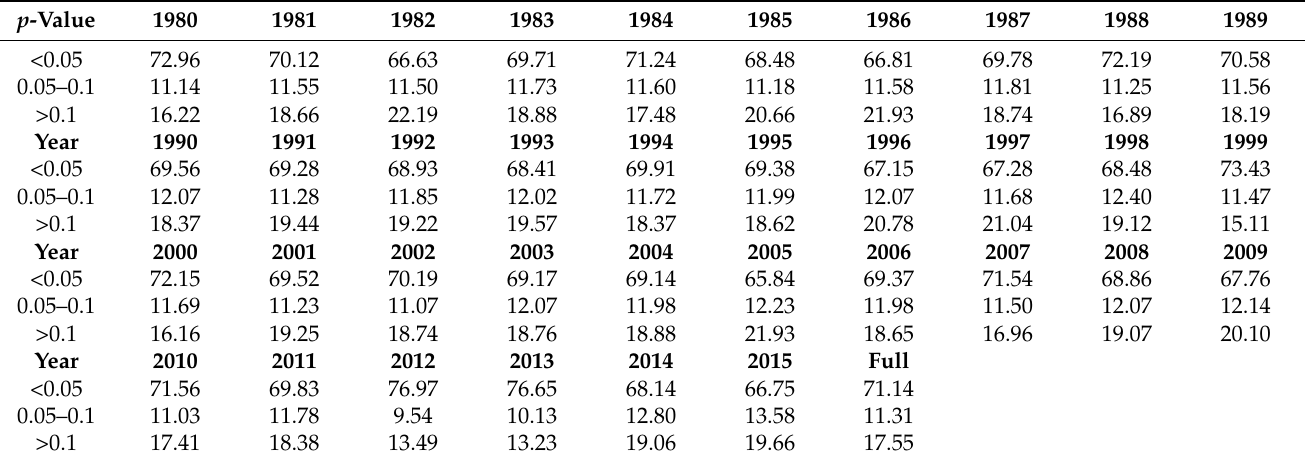
Table 3. Leave-one-out validation from 1980 to 2015 excluding barren land and water (Unit: